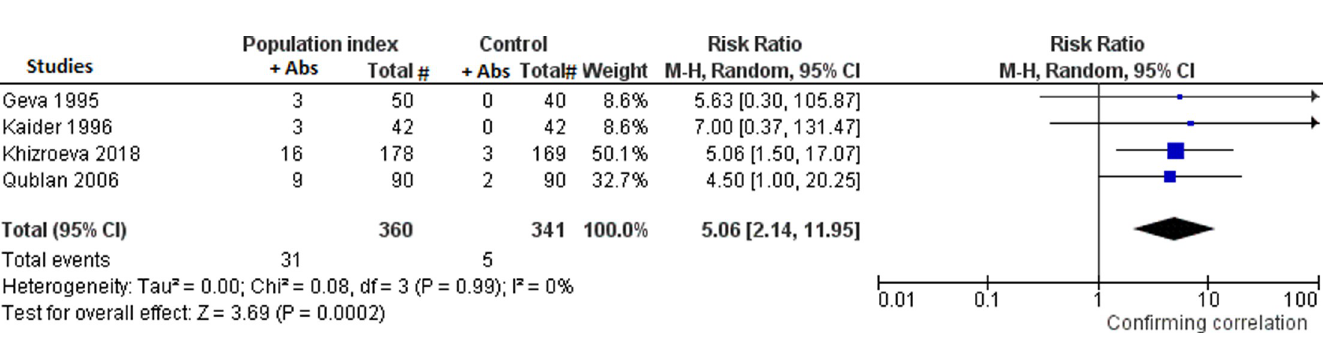
Fig 3. Meta-analyses assessing the risk for implantation failure in relation to the presence or not of anti-PL antibodies in the studies in subgroup A between women with at least two implantation failures in IVF-ET ( population index ) vs . women with one successful IVF-ET ( control ). Fig 3: meta-analysis assessing the risk for implantation failure in relation to the presence or not of anti-CL